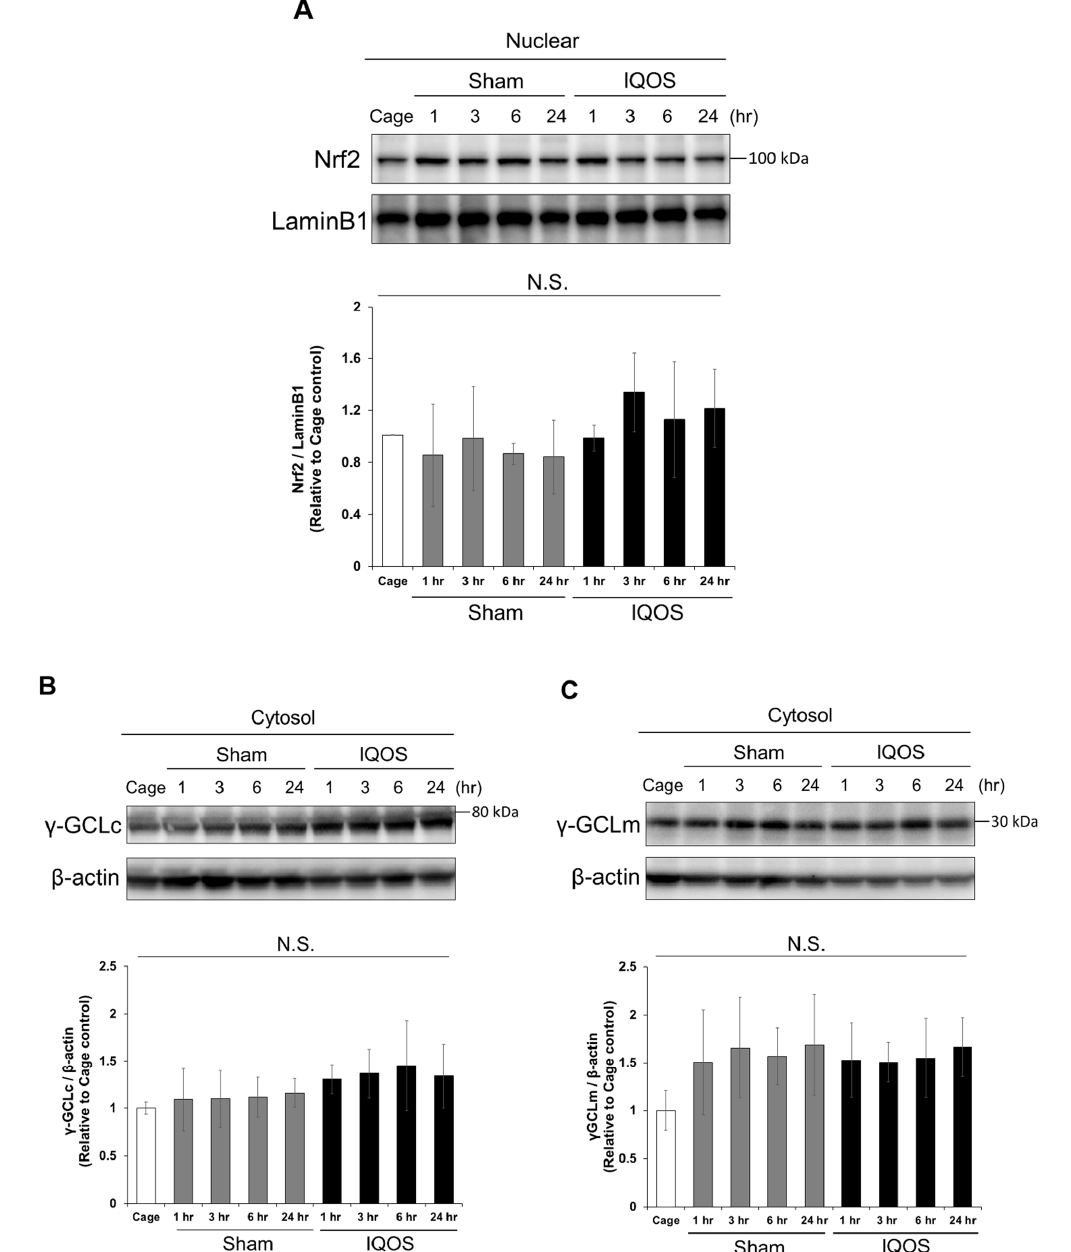
Figure 2. Nrf2 and GCL expression levels in the whole lungs of mice exposed to IQOS. ( A ) Analysis of nuclear Nrf2 expression in the lungs of murine cage controls, sham controls, and at various times after exposure to IQOS. The density of Nrf2 bands were measured, and the ratio of expression normalized to LaminB1 was calculated and expressed as fold-change relative to cage control mice. ( B ) Expression analysis of γ -GCLc in the cytoplasmic fraction of the lungs of murine cage controls, sham controls, and at various times after exposure to IQOS. The density of γ -GCLc bands were measured, and the ratio of expression normalized to β -actin was calculated and expressed as fold-change relative to cage control mice. ( C ) Expression analysis of γ -GCLm in the cytoplasmic fraction of murine lungs from cage controls, sham controls, and at various times after exposure to IQOS. The density of γ -GCLm bands were measured, and the ratio of expression normalized to β -actin was calculated and expressed as fold-change relative to cage control mice. N.S.: not significant. N =